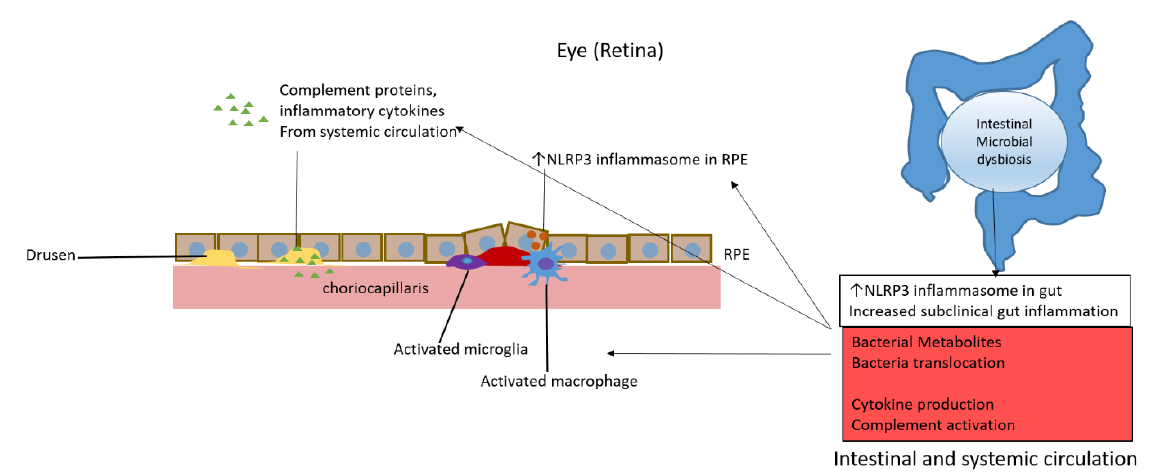
Figure 1. Potential mechanisms of intestinal dysbiosis promotion of age-related macular degeneration through activation of complement, microglia and macrophages, inflammatory cytokines, and inflammasomes.